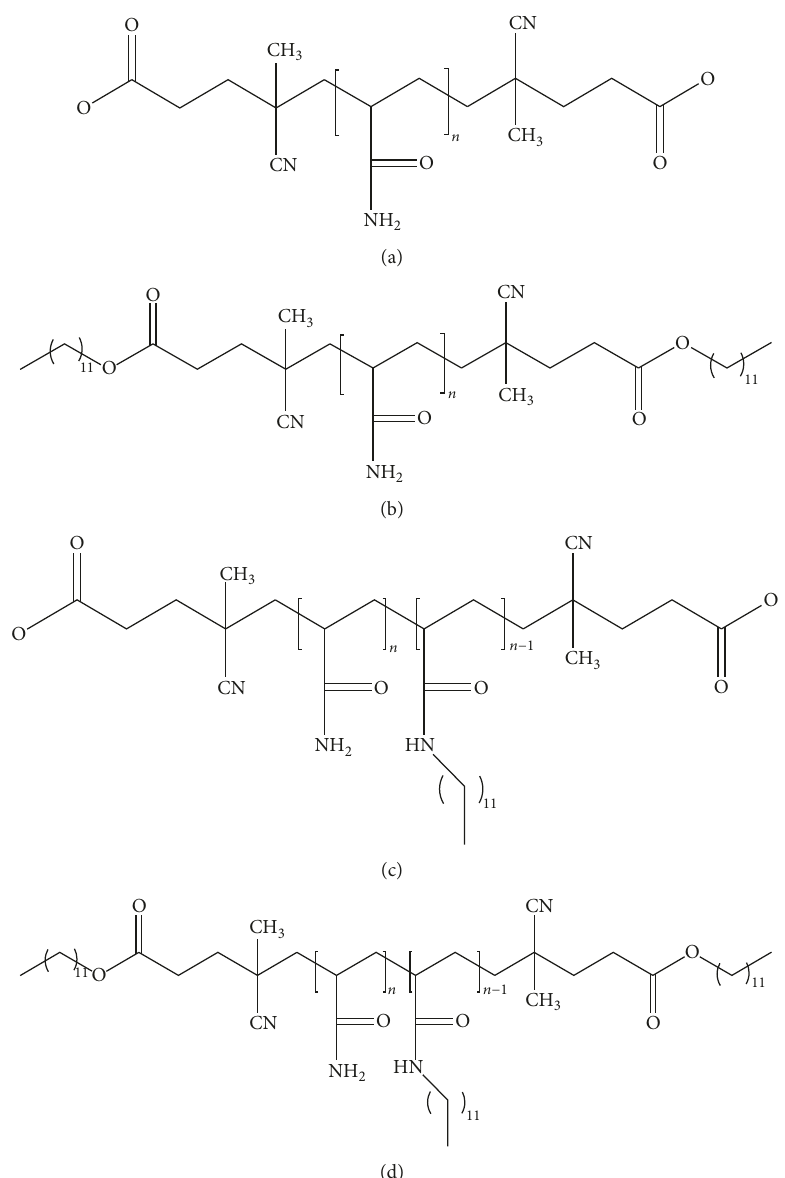
Figure 1: Schematic representation of the synthesized hydrophobic polymers: (a) homopolymer, (b) telechelic, (c) multisticker, and (d)